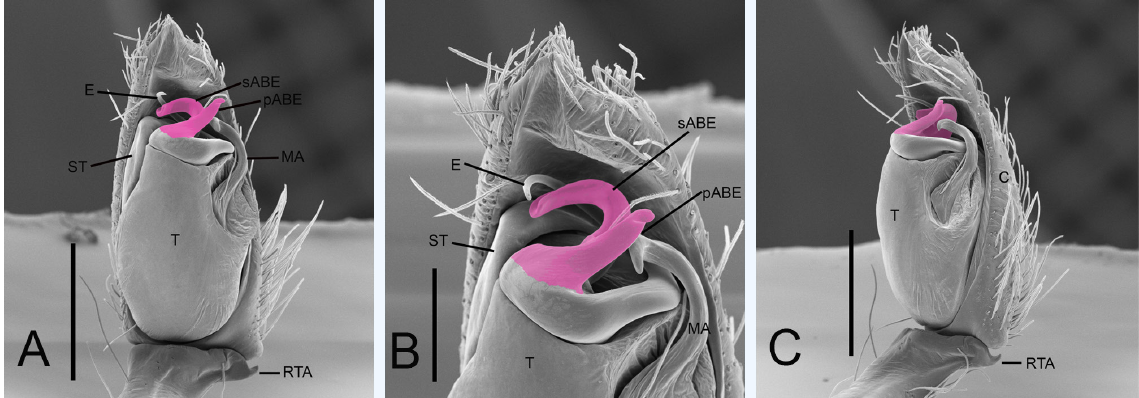
Fig. 31. Tafana orinoco sp. nov., ♂ (MIZA 07062). A . Left palp, ventral view. B . Left palp, ventral view. C . Left palp, retrolateral view. Abbreviations: C = cymbium; E = embolus; MA = median